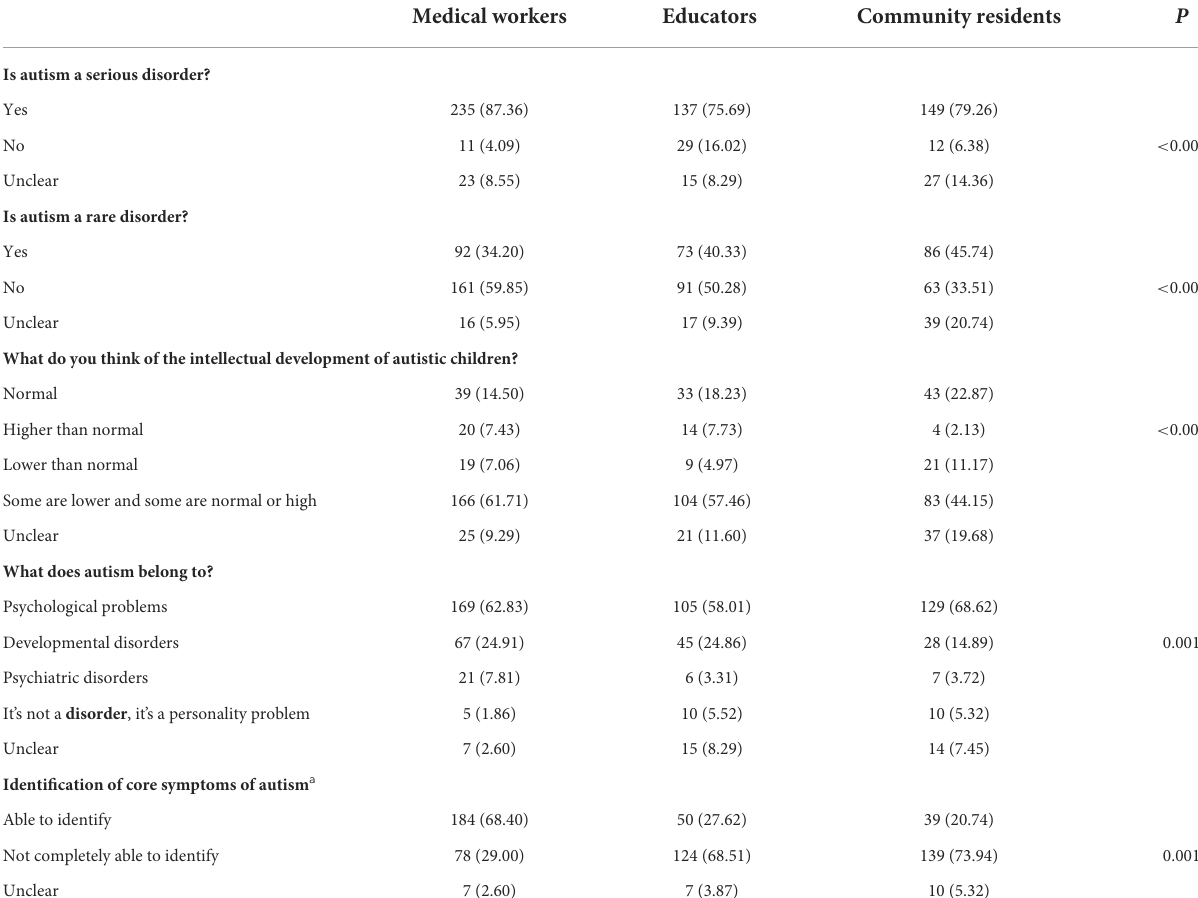
TABLE 2 Awareness and baseline knowledge of ASD among the three groups ( n , %). Medical workers